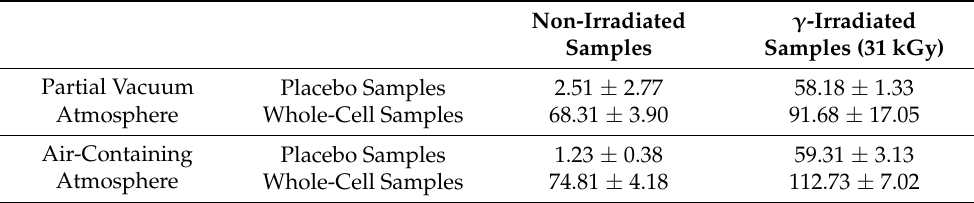
Table 1. Experimental antioxidant capacities (i.e., TEAC values) of various stabilized whole-cell progenitor tenocyte samples (i.e., containing 7.5 × 10 6 cell equivalents/vial) or lyophilizate placebo samples containing two types of vial atmospheres (i.e., partial vacuum or atmospheric pressure air), respectively 1 . Values are presented as means assorted to the corresponding standard